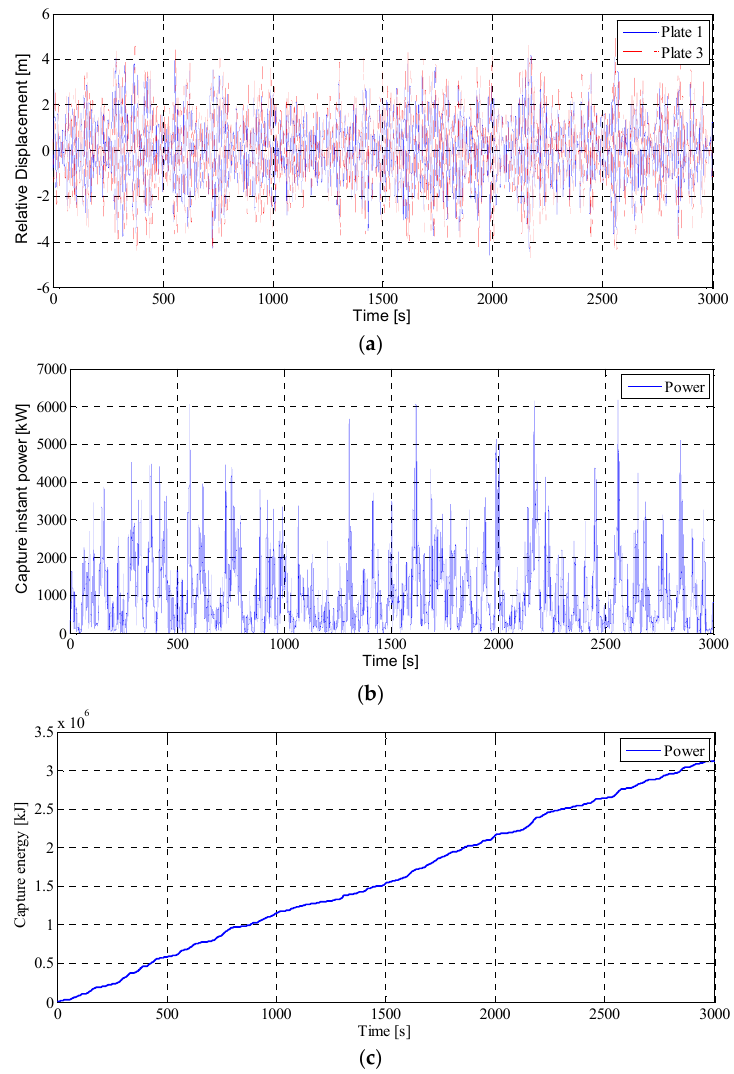
Figure 20. ( a ) The relative displacement of Plate1 and Plate3 under IRW ‐ 1; ( b ) the captured instant power of the THPEH system under IRW ‐ 1; ( c ) the captured energy of the THPEH system under IRW ‐ 1.